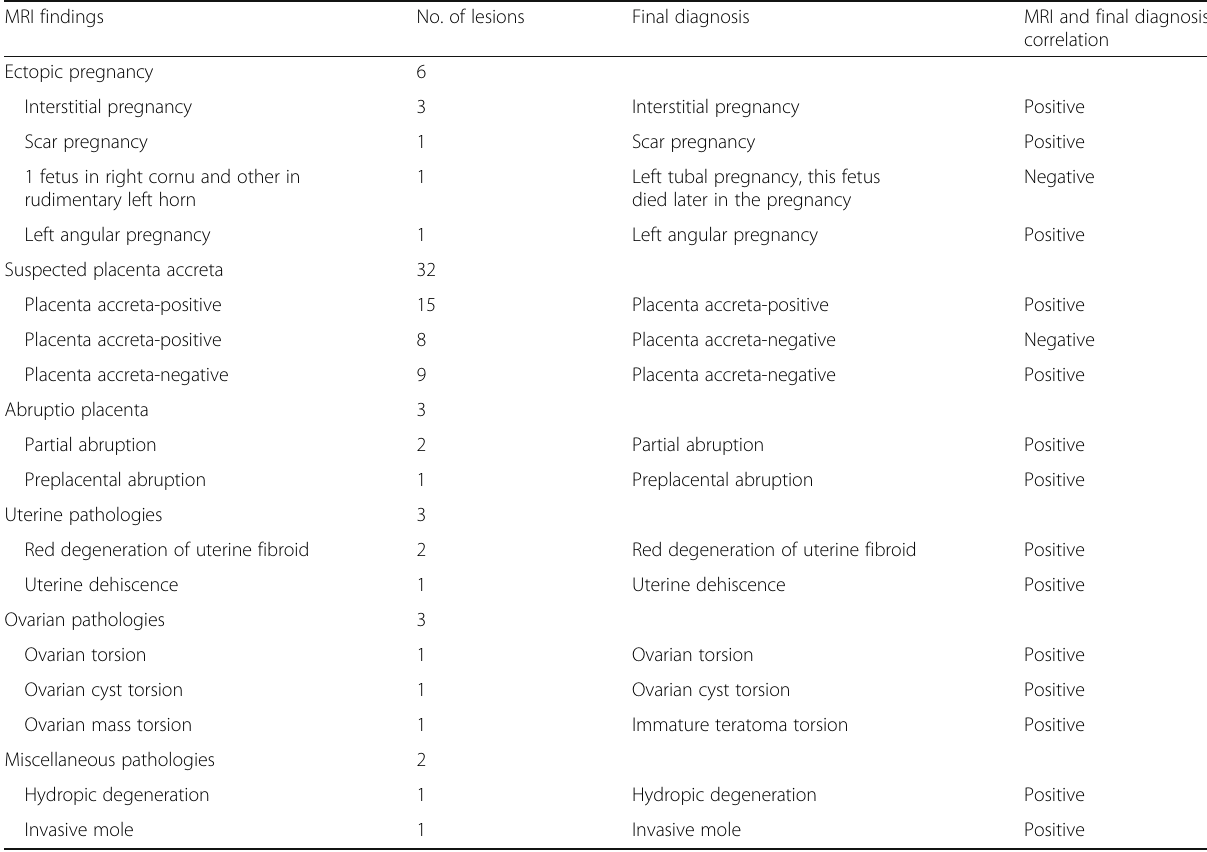
Table 1 Showing the MRI findings in the 48 patients and the final diagnosis as confirmed by surgery/histopathology MRI